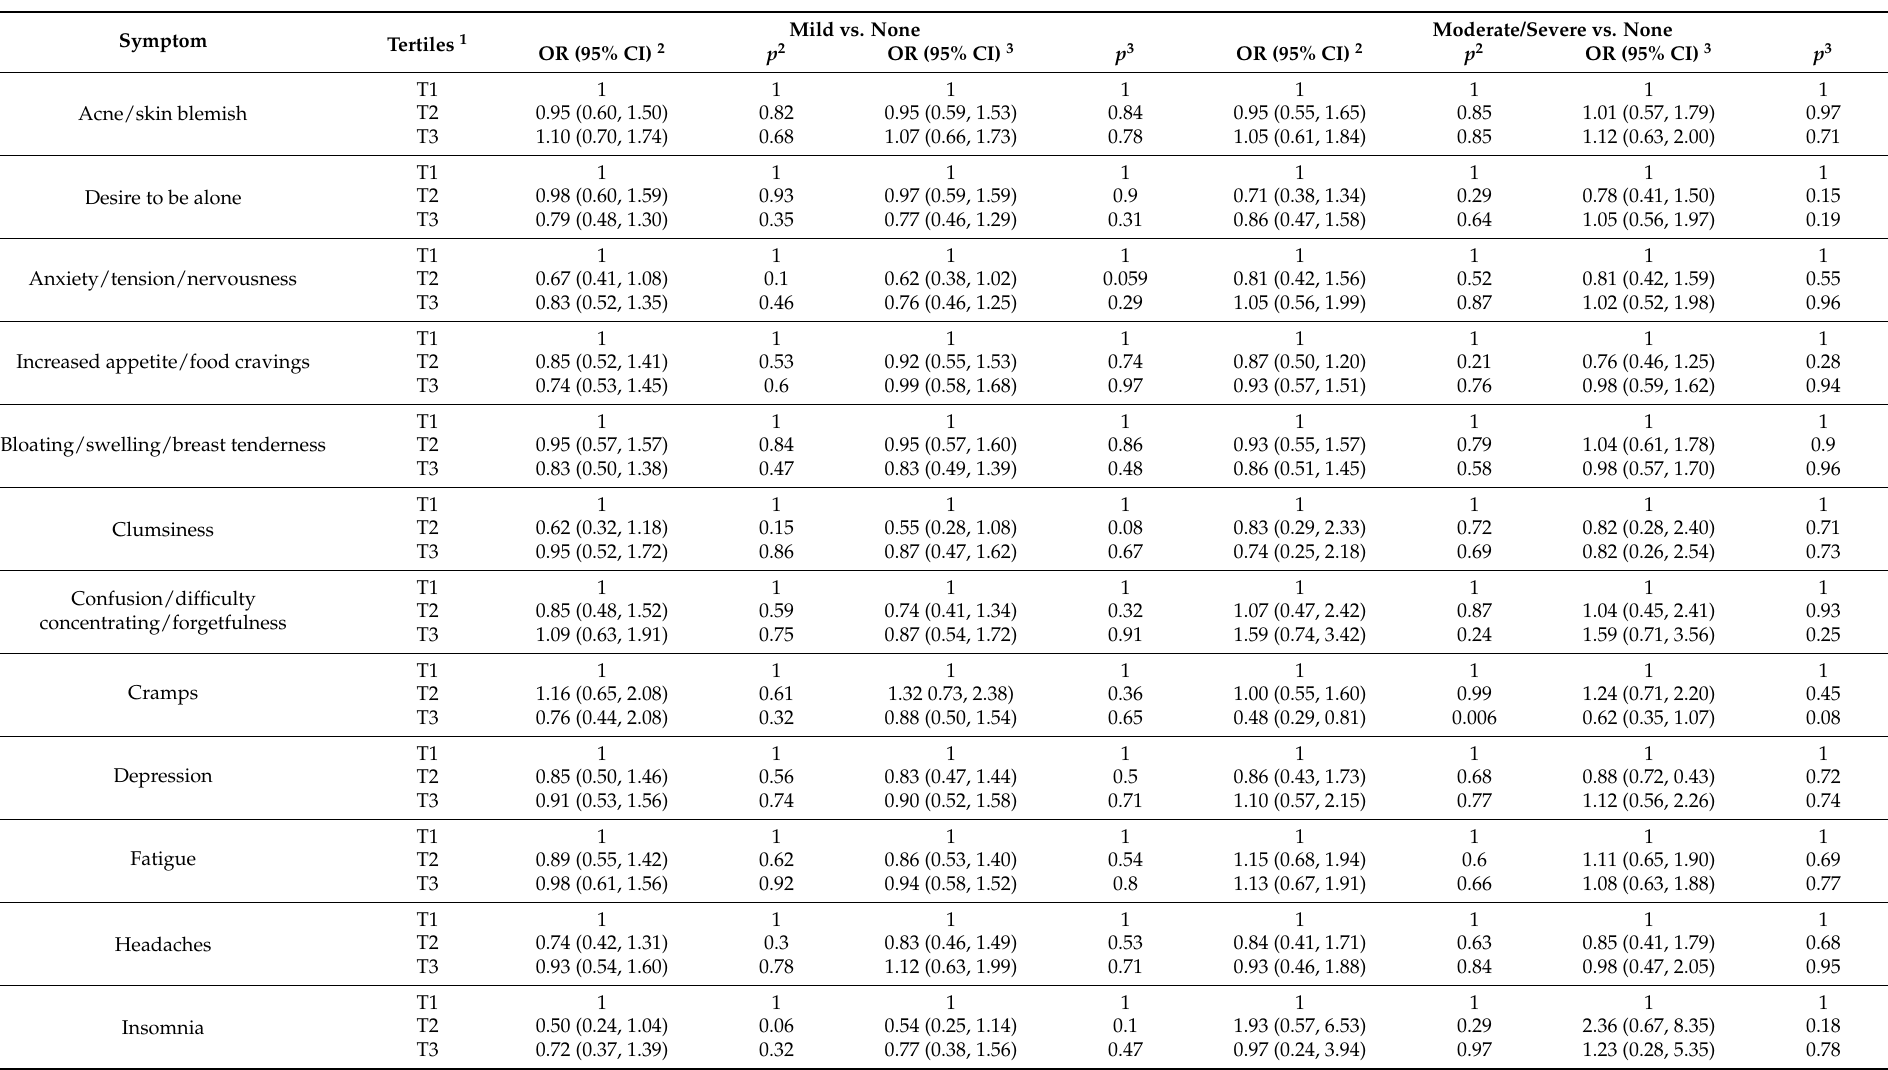
Table 6. Unadjusted and adjusted Odds Ratios and 95% CIs for the association between tertiles of plasma lutein and premenstrual